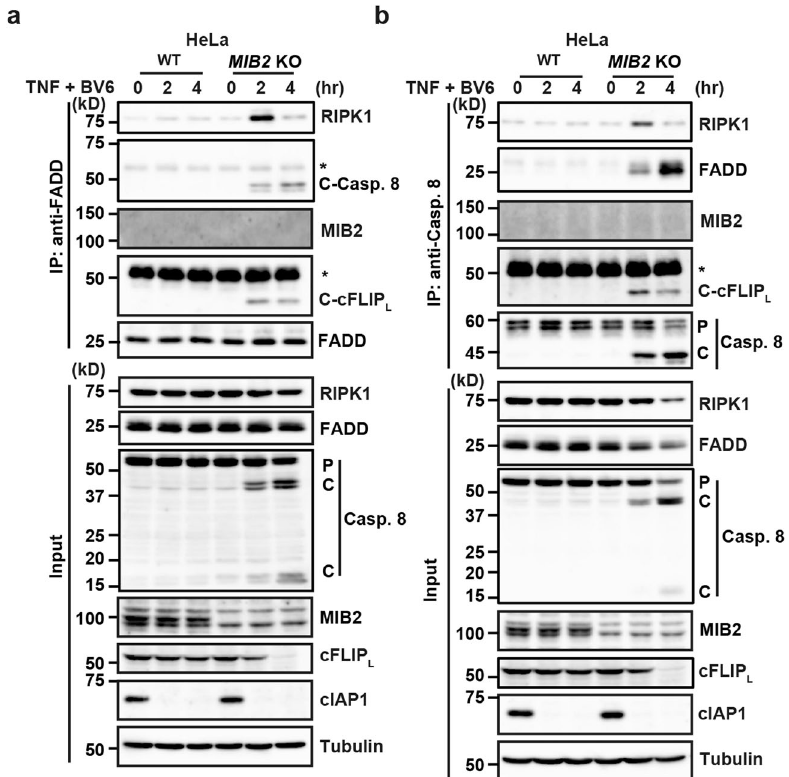
Fig. 7 Complex IIb formation is facilitated in MIB2 KO HeLa cells. a , b WT and MIB2 KO HeLa cells were stimulated with TNF (10 ng/ml)/BV6 (0.1 μ M) for the indicated times, and cell lysates were immunoprecipitated with anti-FADD ( a ) or anti-caspase 8 ( b ) antibodies. Immunoprecipitated proteins were analysed by immunoblotting with the indicated antibodies. Protein expression was veri fi ed by immunoblotting with the indicated antibody. *Cross-reacted band; C-Casp. 8, cleaved caspase 8; C-cFLIP L , cleaved cFLIP L . P and C indicate proform and cleaved, respectively. All results are representative of two independent